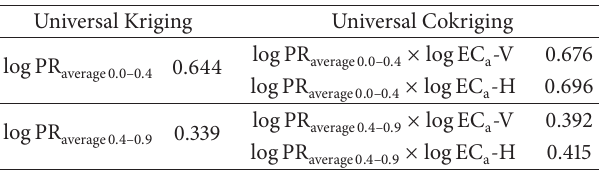
Table 5: Correlation coefficient ( 𝑟 ) between measured and esti- mated data by kriging and cokriging for selected